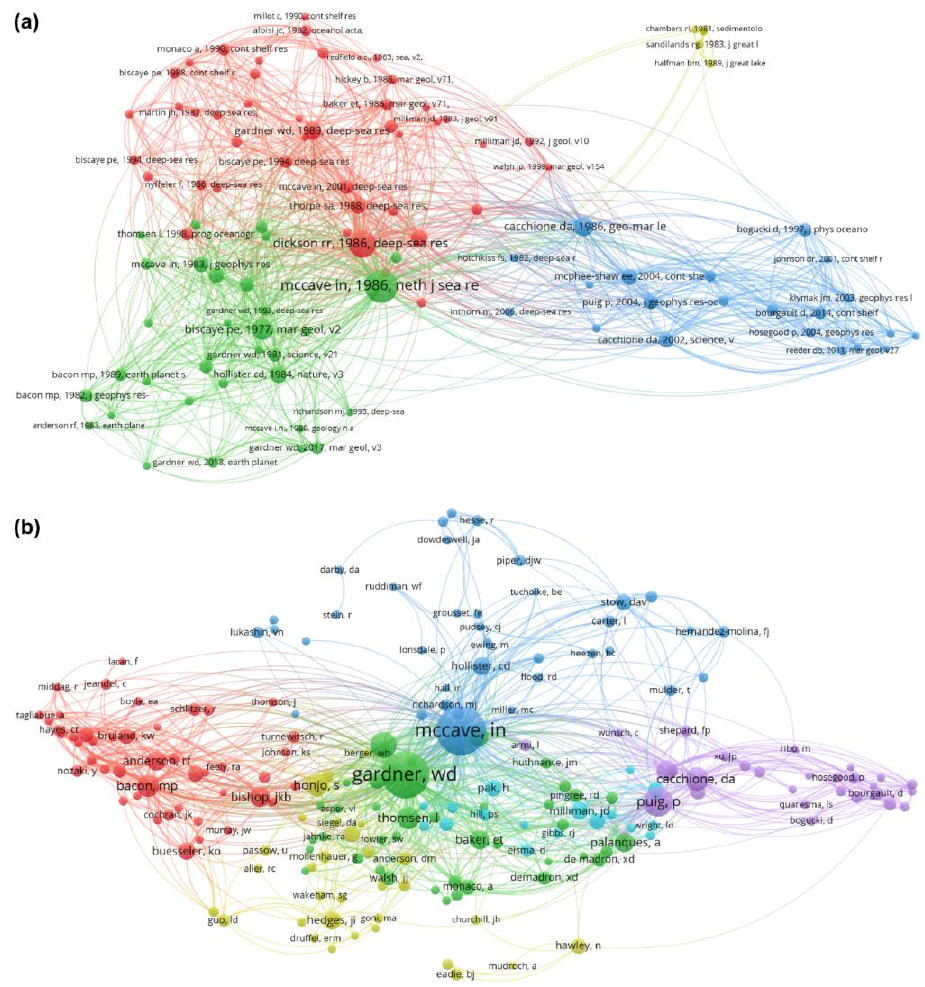
Figure 5. Co-citation reference analysis of the publications related to nepheloid layers from 1990 to 2022. ( a ) Publication co-citation analysis (threshold 15 co-citations, 27,062 cited references in the network; here, 101 publications with the strongest connection displayed). ( b ) Author co-citation analysis (threshold 25 co-citations, 2199 cited authors in the network; here, 204 authors with the strongest connection displayed).